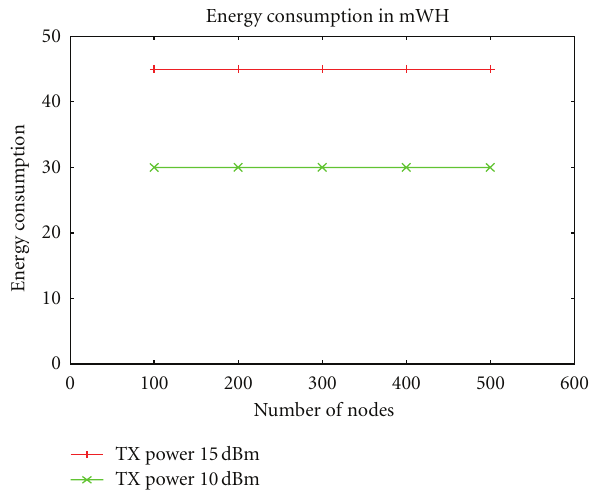
Figure 5: Number of nodes versus energy